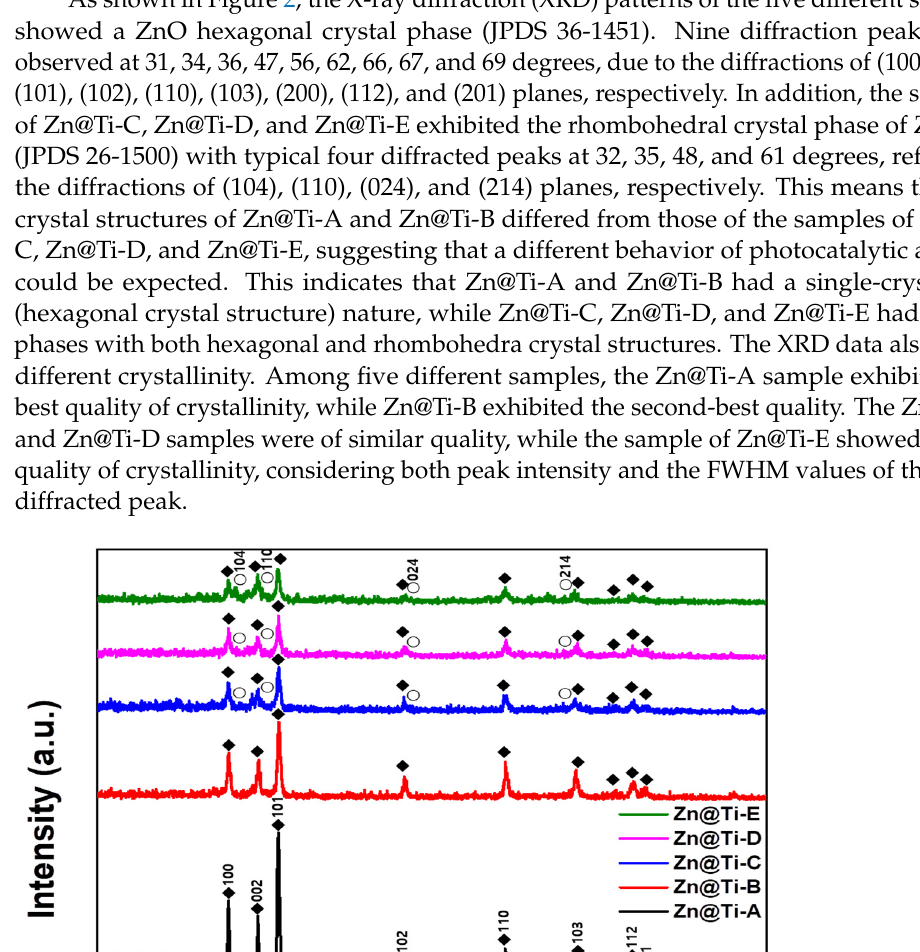
Figure 2. XRD patterns of Zn@Ti-A, Zn@Ti-B, Zn@Ti-C, Zn@Ti-D, and Zn@Ti-E nanocomposites synthesized by an atmospheric soft plasma jet.